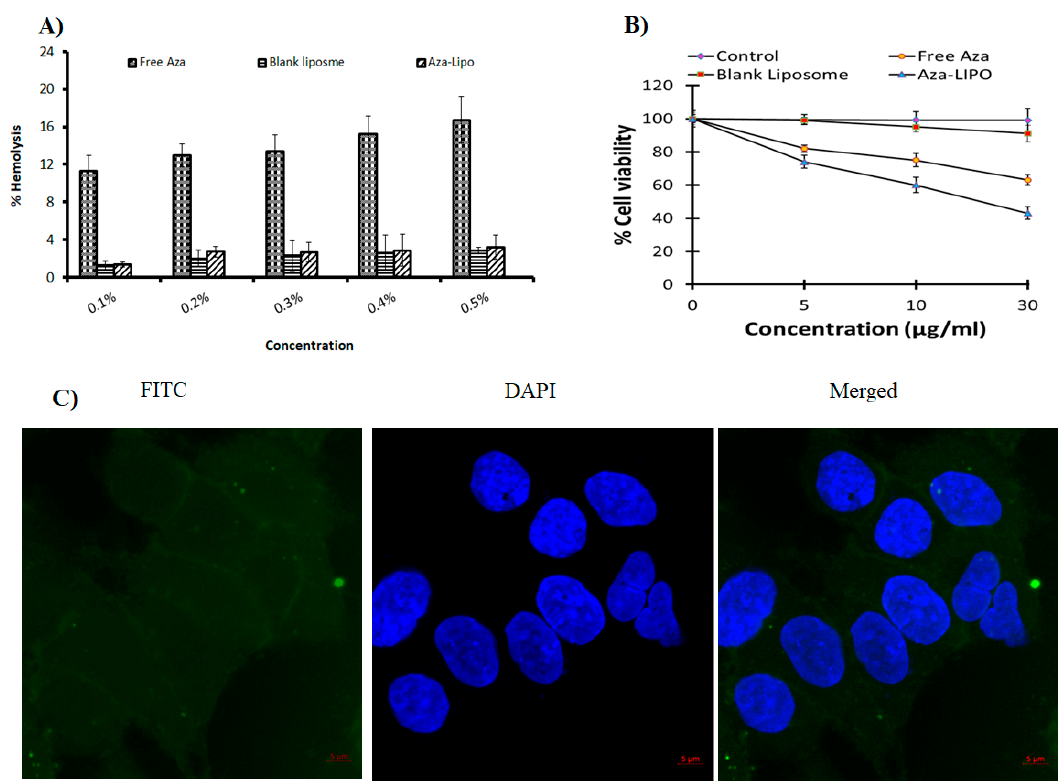
Figure 9. ( A ) Hemolysis toxicity profile (n = 6), ( B ) cytotoxicity assay (n = 6) and ( C ) confocal microscopy of the developed formulations.